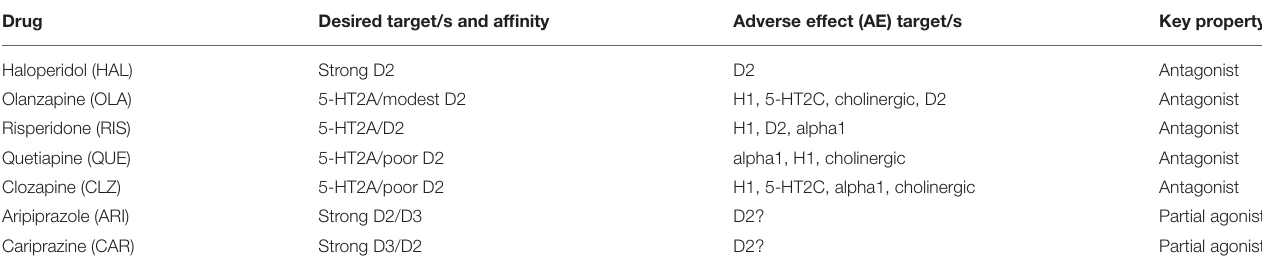
TABLE 1 | Examples of antipsychotics considered in the APP context. Drug